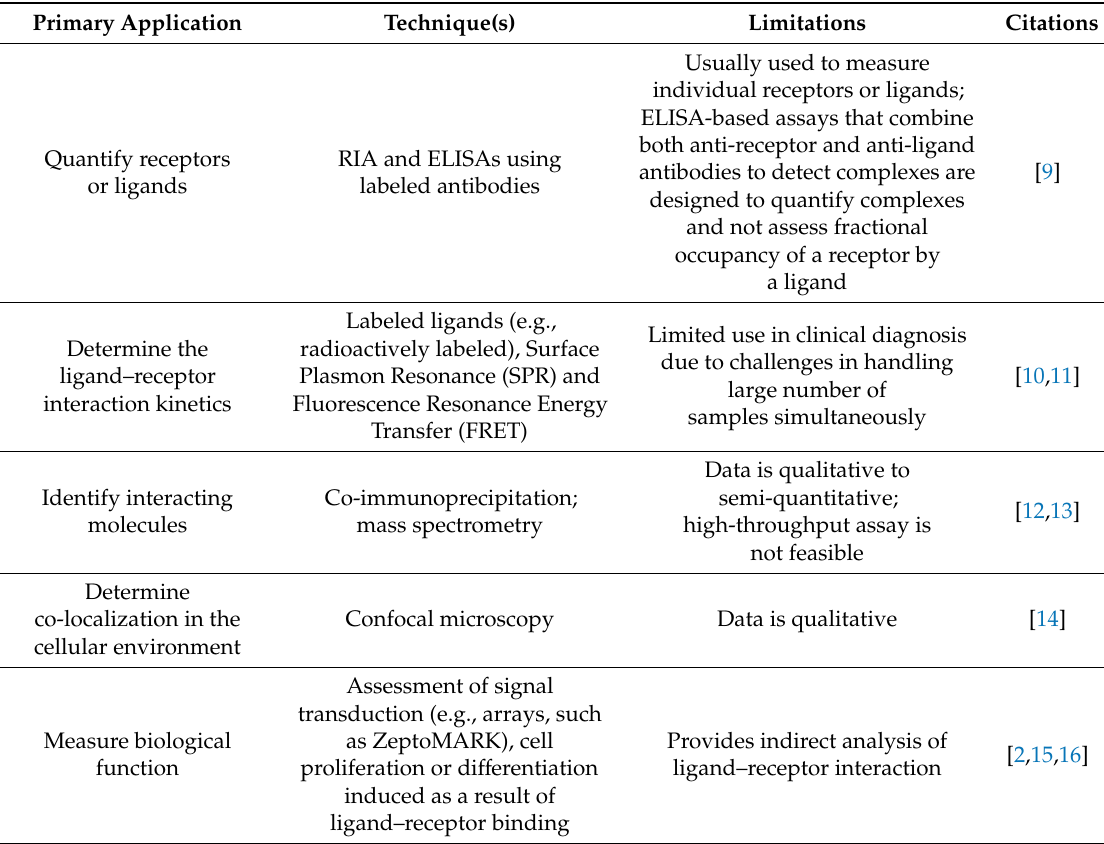
Table 1. Current technologies and their applications in ligand–receptor